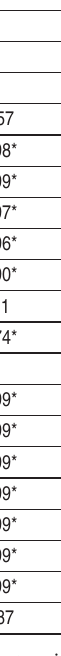
Table 12. Jump frequency criterion - US stock index futures (US-SIF), US Treasury bond futures (US-TBF) and US spot exchange rates (US-SER) markets US-SIF US-TBF US-SER ES WW